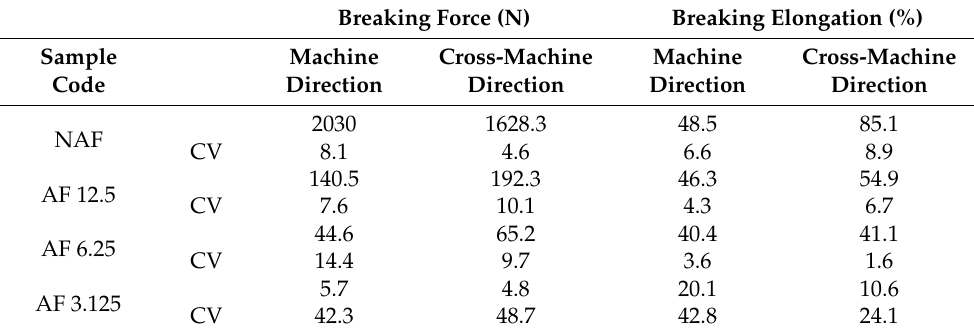
Figure 6. Poisson’s ratio of the AF 6.25 sample with the longitudinal strain ( a ) and corresponding fabric deformation in the machine-direction ( b ) (LS–longitudinal strain (%), LD–longitudinal displacement (mm)). Table 3. Tensile properties‘ measurements (CV (%)–coefficient of